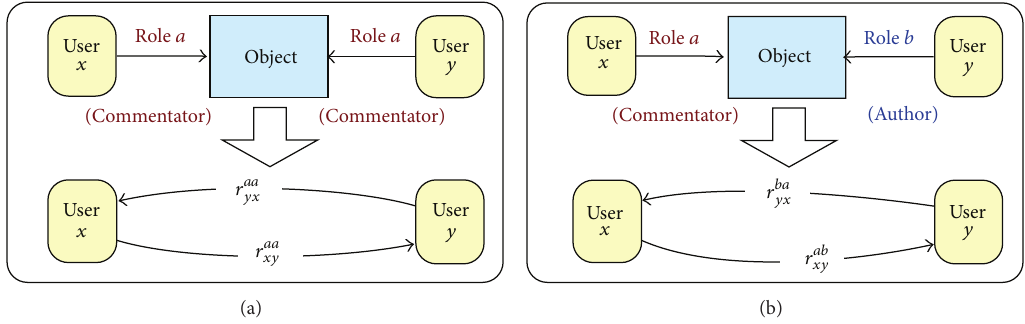
Figure 2: The object-based relation with equal roles: commentator (a) and different roles: commentator and author (b).